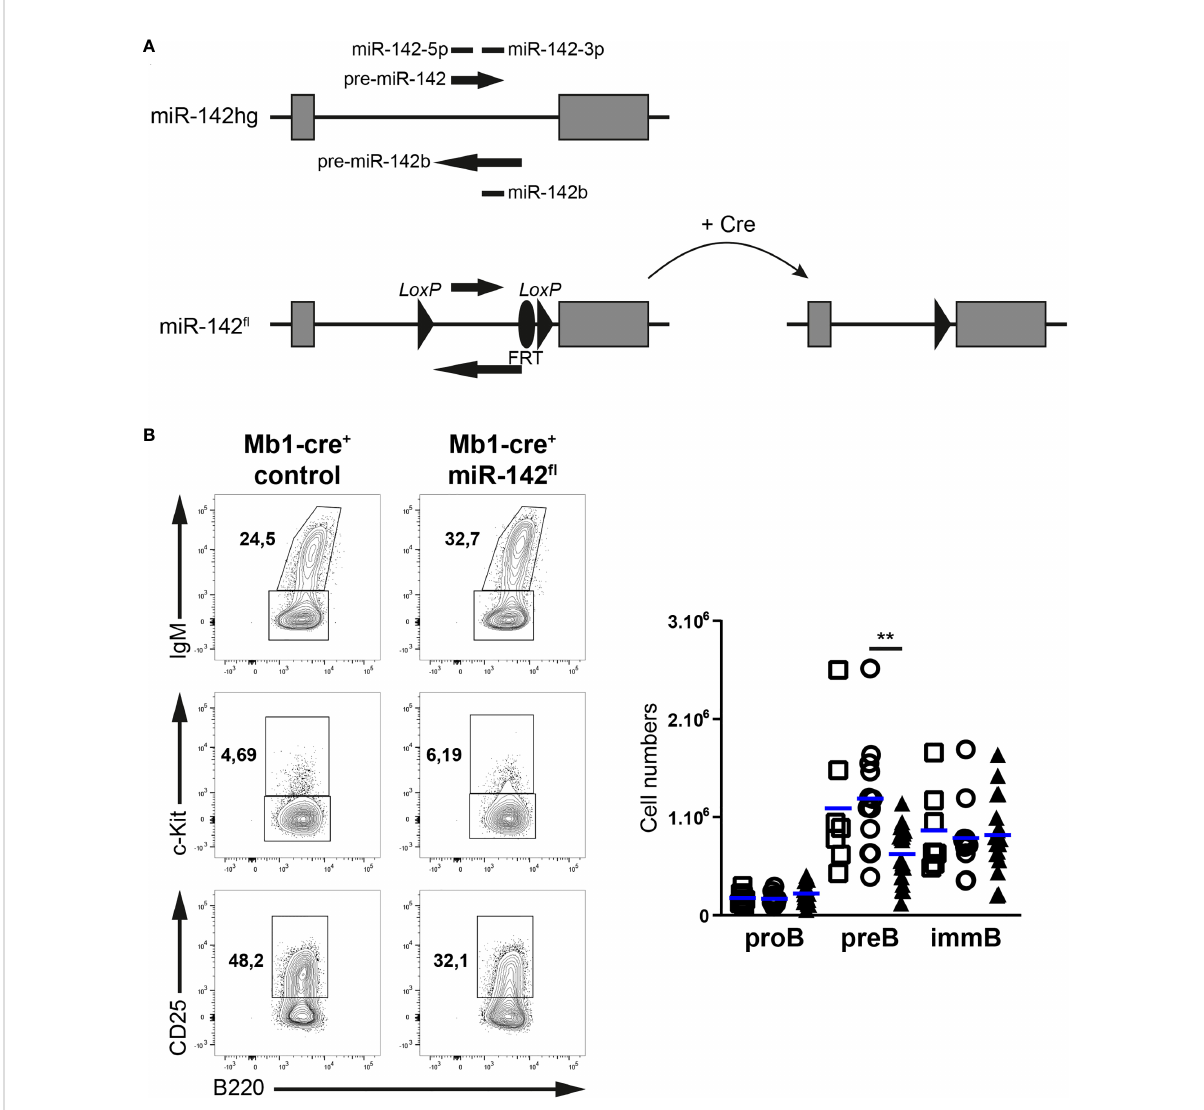
FIGURE 1 Pre-B cellularity is reduced in Mb1-cre + miR-142 fl mice. (A) Scheme of the conditional gene targeting strategy: a 677 bp fragment of the miR- 142 host gene (miR-142hg) containing the sequences of the precursor and mature forms of miR-142 and miR-142b was fl anked with loxP sites (miR-142 fl ) to permit Cre-mediated elimination. FRT site: remnant of a deleted selection cassette used during the work with embryonic stem cells. (B) Left: fl ow cytometry of IgM + immature B cells within CD19 + B220 + CD93 + progenitor B cells, as well as c-Kit + pro-B cells and CD25 + c- Kit – pre-B cells within IgM – progenitor B cells in the bone marrow of Mb1-cre + control and Mb1-cre + miR-142 fl mice. Right: bone marrow pro-, pre- and immature B cell numbers in Mb1-cre – ( □ ), Mb1-cre + ( ○ ) and Mb1-cre + miR-142 fl ( ▲ ) mice. n = 7-18 per group in 18 independent experiments. Each symbol represents one mouse and horizontal blue lines indicate the mean. **, P ≤ 0.01 by one-way